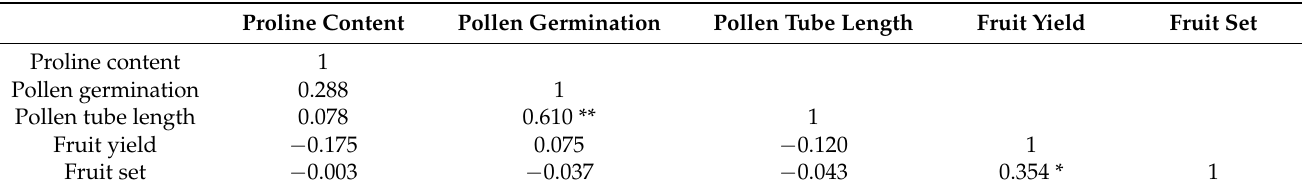
Table 2. Correlation between biochemical and reproductive traits at high temperatures (40 ◦